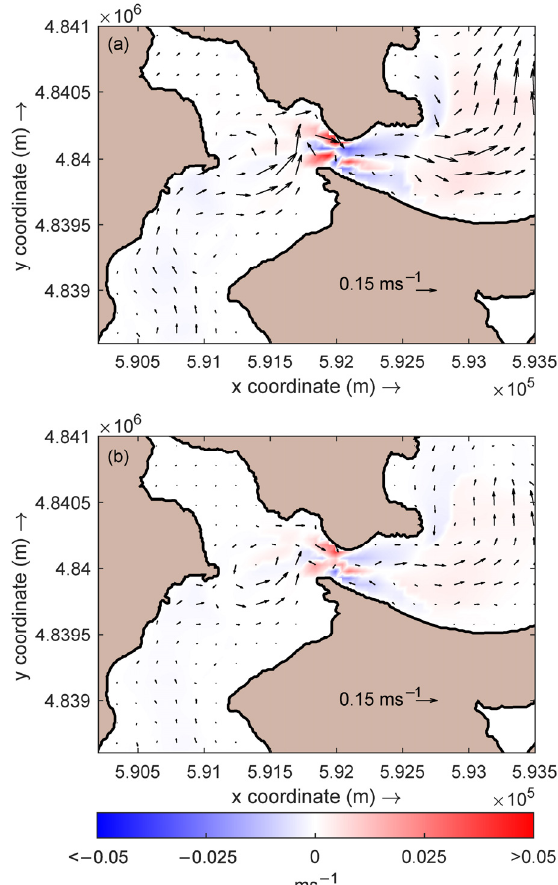
Figure 13. Residual flow pattern in Ria de Ortigueira under case study CS8 conditions (vectors); differences in the residual flow magnitude between altered flow and reference situation (CS8–CS4) (colour map). ( a ) Surface layer; ( b ) bottom layer.